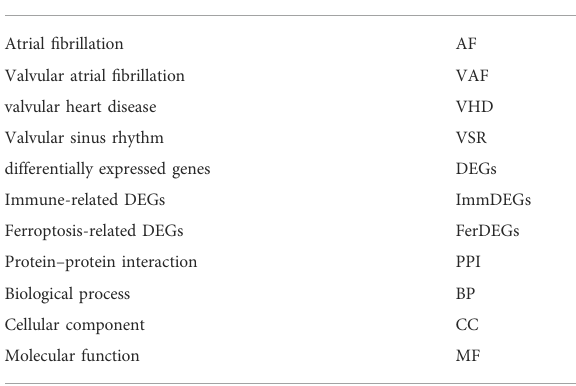
TABLE 1 Nonstandard Abbreviations and Acronyms.